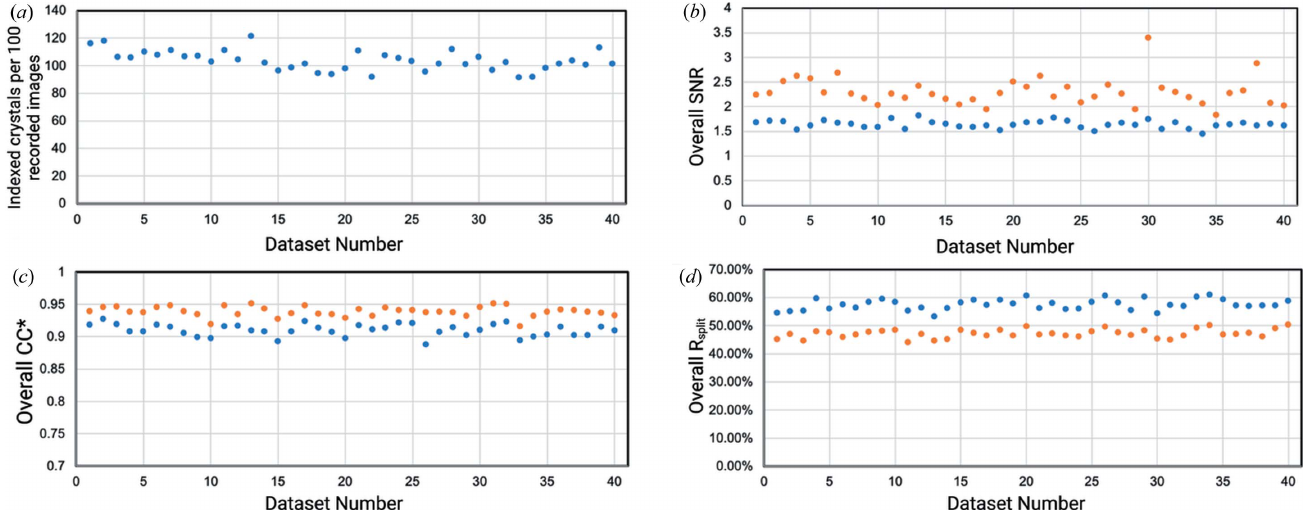
Figure 6 Crystallographic metrics and indexing rates for all 40 NhGH11 datasets. ( a ) Indexing rate, ( b ) SNR, ( c ) CC* and ( d ) R split values for all 40 datasets, each consisting of 1000 recorded detector frames within one run. In ( b ), ( c ) and ( d ), values from processing without partiality modeling are depicted in blue and values from processing with partiality modeling are depicted in